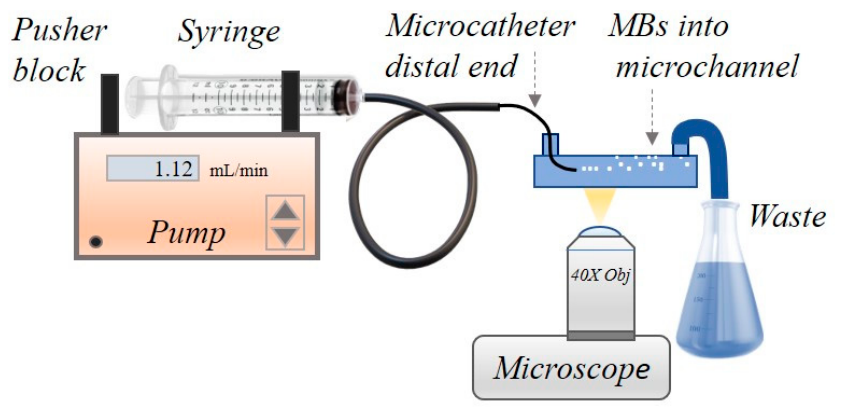
Scheme 2. Sketch of the setup for microcatheter infusion and real-time imaging of the PVA MB dispersion in microfluidic